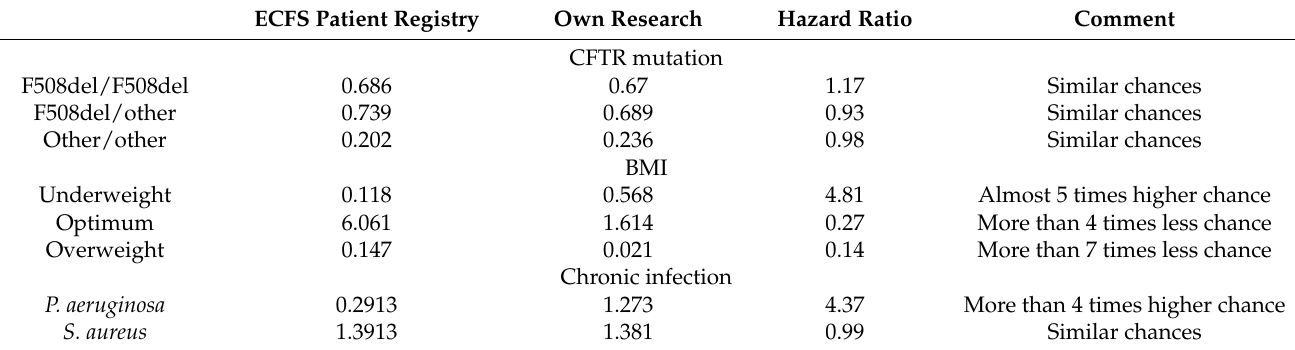
Table 2. Hazard ratios of CFRD for genetics, BMI, and bacteria *. ECFS Patient